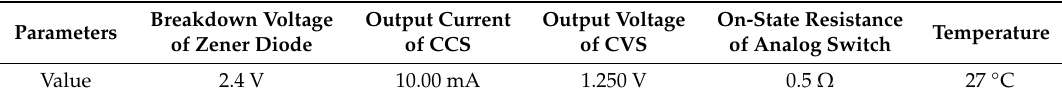
Table 1. Parameters used in the simulation model.